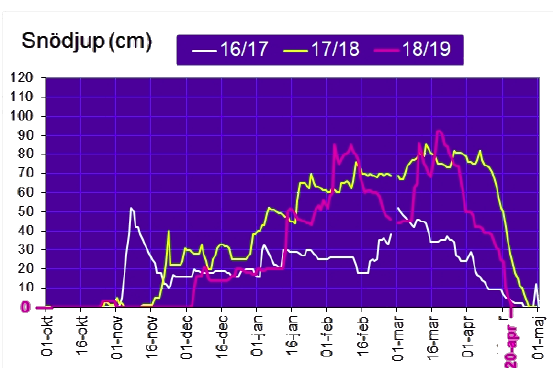
Figure 16. Snow Depth Chart for Skellefteå extracted from Reference [54]. The pink curve corresponds to the 2018/2019 period.